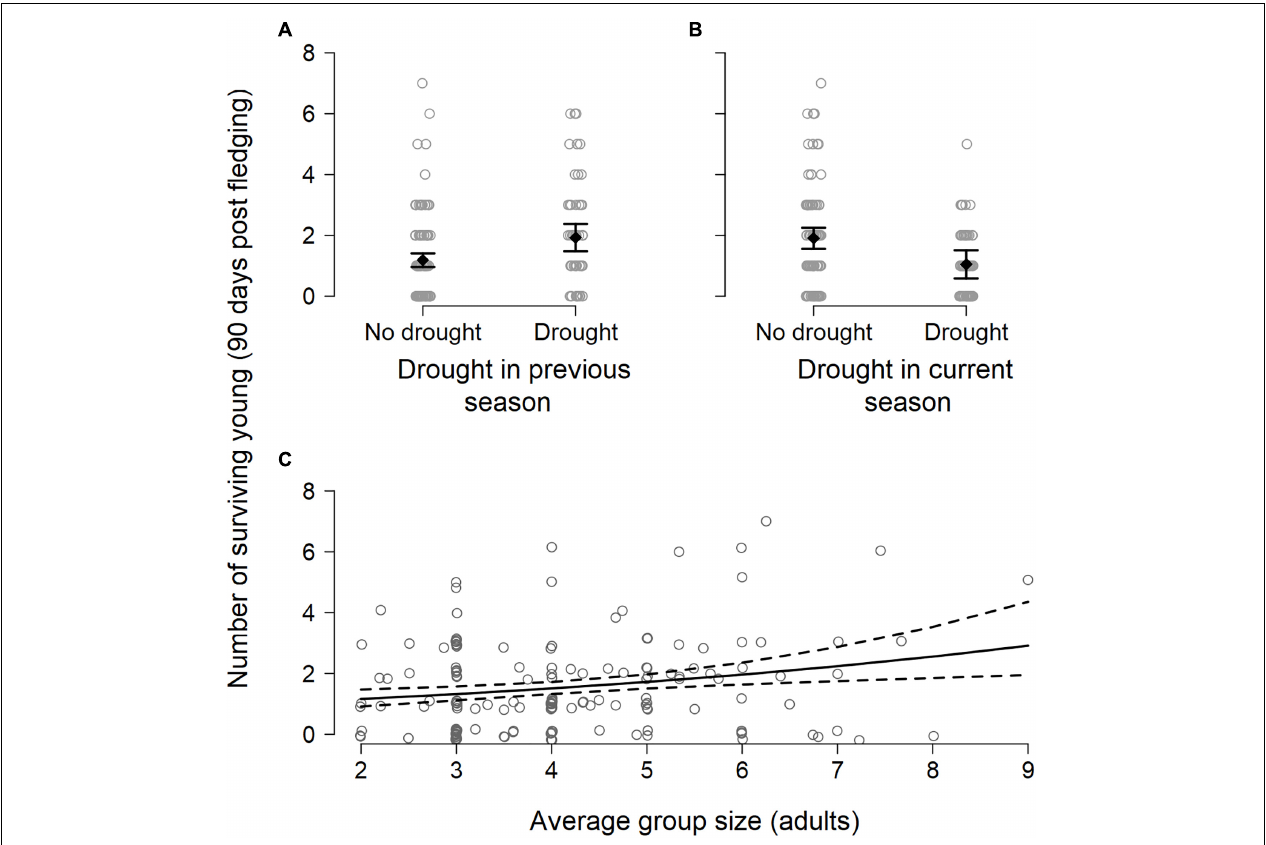
FIGURE 3 | Number of surviving young (90 days post fledging) produced per group per breeding season in relation to (A) the occurrence of drought in a previous breeding, showing the model-predicted mean (black filled diamond) ± 1.96 × standard error (black whiskers), (B) the occurrence of drought during the current breeding season, and (C) average group size during the current breeding season. Data are jittered for improved